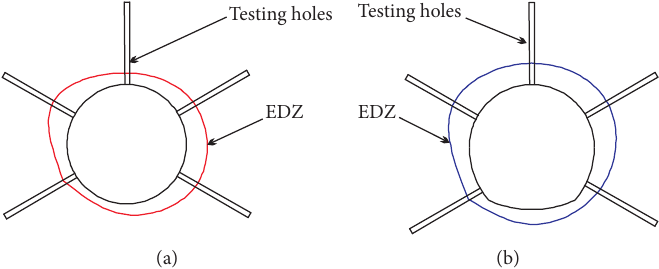
Figure 4: A schematic diagram of testing holes arrangements in diversion tunnels: (a) for TBM sections and (b) for drilling-blasting sections.